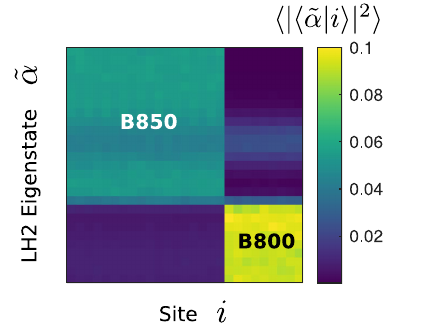
FIG. 7. B800-B850 mixing in a LH2 ring. Disorder-averaged populations of LH2 mixed B800-B850 eigenstates j ˜ α i on differ- ent sites j i i . The eigenstates are clearly divided into two blocks, representing the fact that there is negligible coherent mixing between B800 and B850 excitons. The ensemble average is obtained from 10 4 realizations of static disorder.